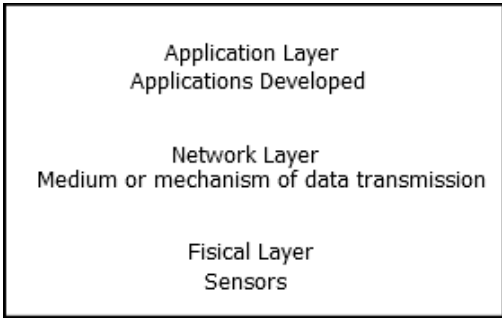
Figure 1. Internet of things (IoT) architecture [7,8,10].